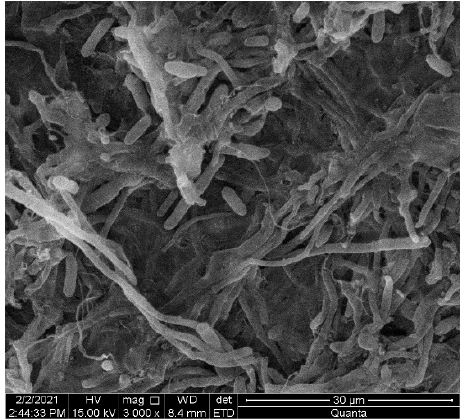
Figure 3. The morphological structure of Cordyceps strain